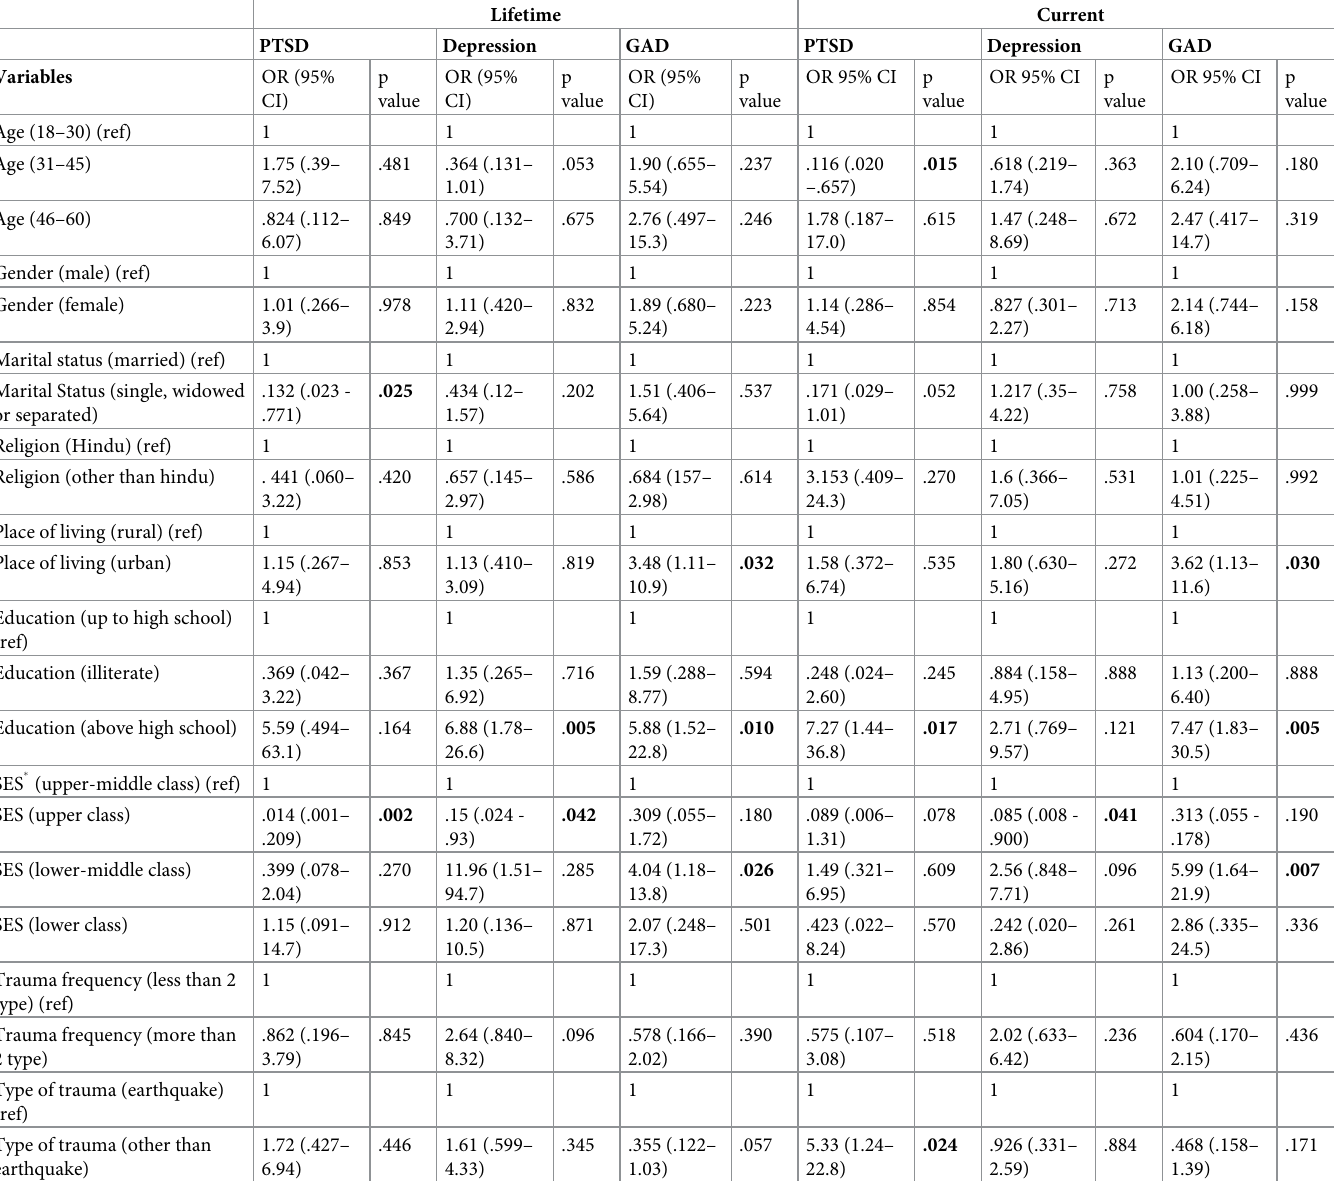
Table 4. Factors independently associated with psychiatric disorders among patients with trauma